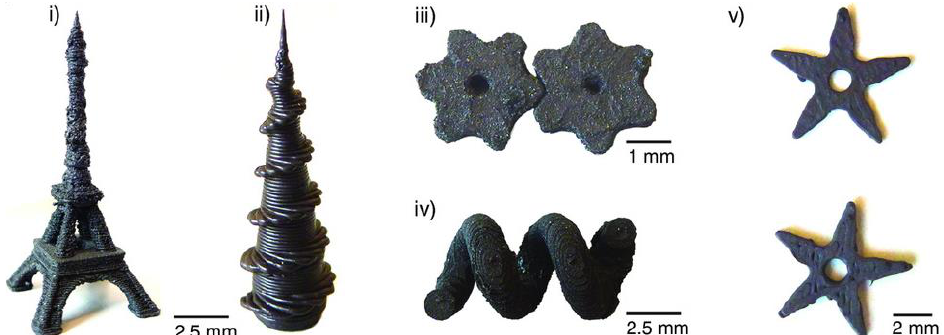
Figure 12. Three-dimensionally printed structures: ( i ) the Eiffel Tower at a scale of 1:1200 printed with NdFeB/PA12, ( ii ) complex helical structure combined with a conical body printed with the SrFe 12 O 19 /PA12, ( iii ) two 3D-printed NdFeB/PA12 gears with magnetization perpendicular to their axis, ( iv ) magnetic helix 3D-printed from NdFeB/PA12 and a water-soluble support material, and ( v ) 3D-printed ninja stars from SrFe 12 O 19 /PA12. Reprinted from [92], originally published under a CC-BY license.